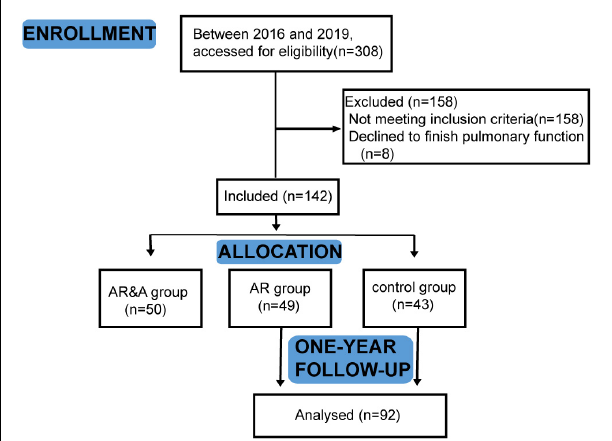
FIGURE 1 | Flow chart of the study. In total, 142 participants were divided into AR group, AR&A group, and control group. After enrollment, they took the tidal breathing pulmonary function test. Participants in AR group and control group were prospectively followed up for 1 year. AR group, patients with single AR; AR&A group, AR patients combined with asthma; and control group, healthy